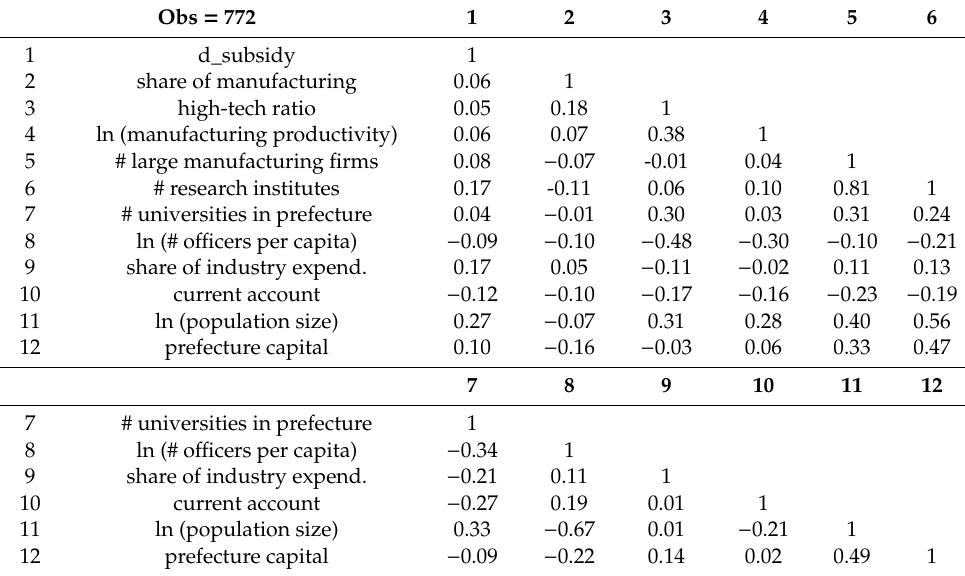
Table 2. Correlation matrix of variables used in the first empirical